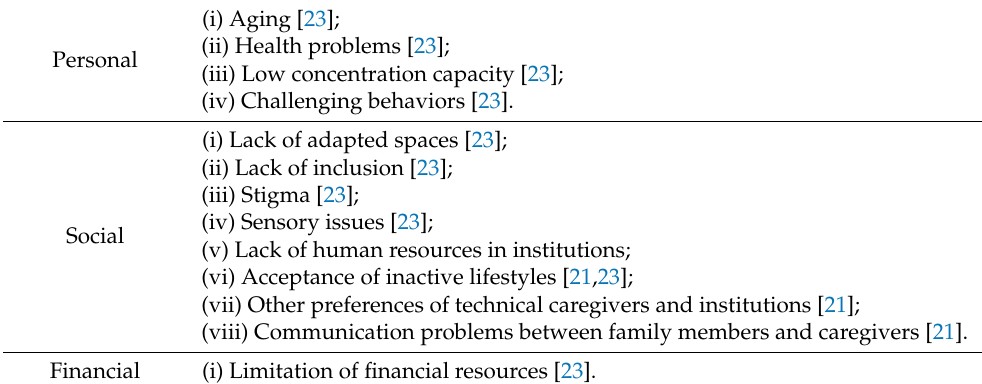
Table 5. Barriers to PA practice in the perception of technical